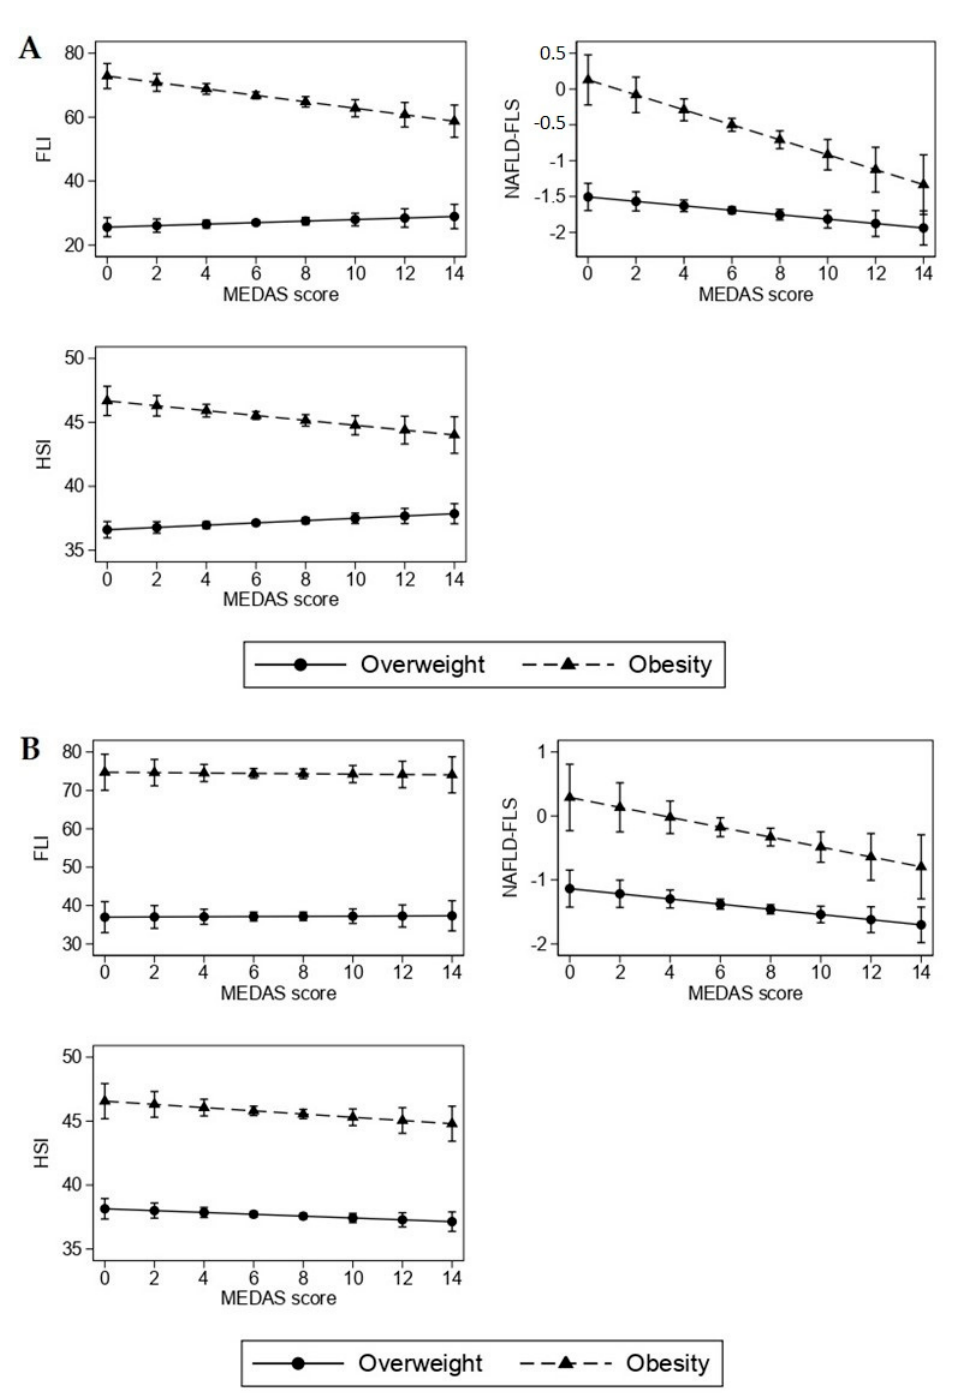
Figure 2. Association of Mediterranean diet (MEDAS score) with indices of fatty liver according to BMI category in premenopausal ( A ) and postmenopausal ( B )